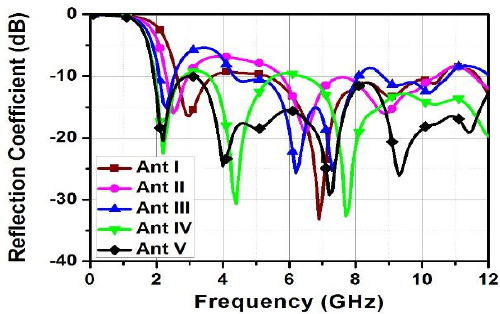
Figure 4. Evolution of the antenna linked with port 1.